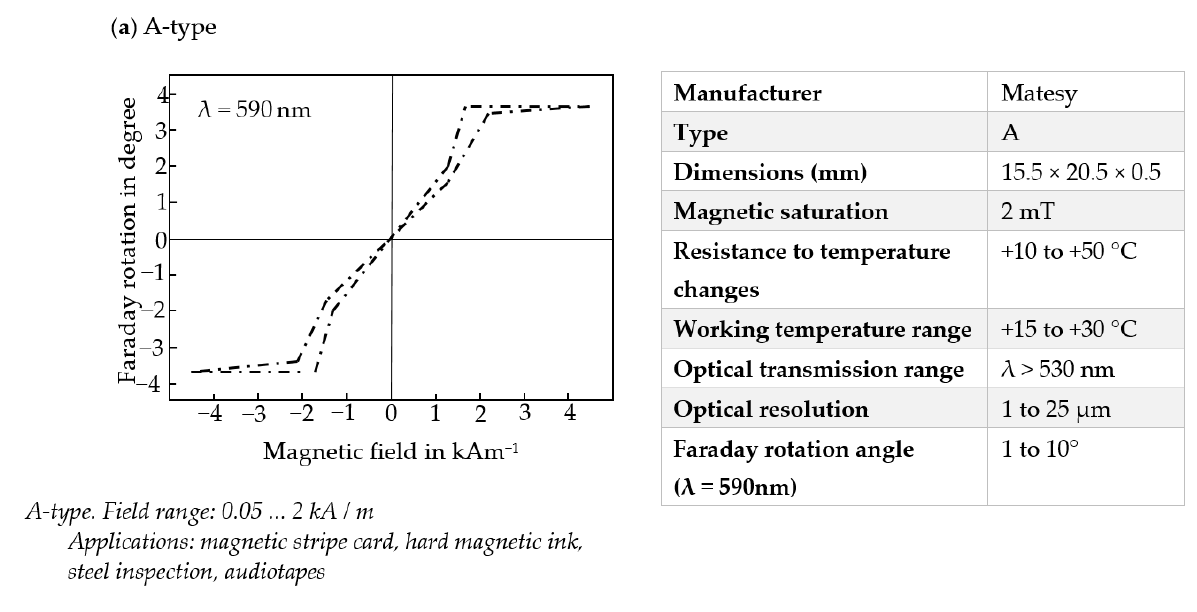
Figure 8. Magneto-optical sensor; ( a ) the photo of the A-type MO sensor in the protective packaging. ( b ) schematic showing the functional layers of the Magneto-Optical Indicator Film